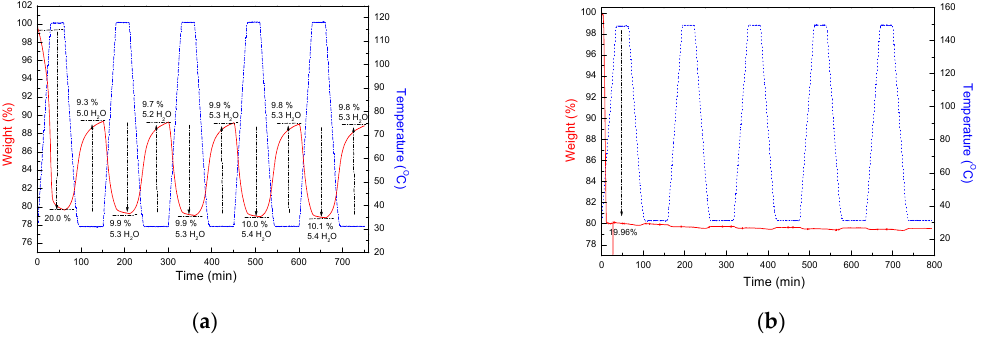
Figure 5. TG measurements of ( a ) 1 and ( b ) 2 during the cyclic de-/rehydration processes, which were repeated five times. Solid red line: the variation in weight loss with time; blue dash-dot line: the variation in temperature with time.